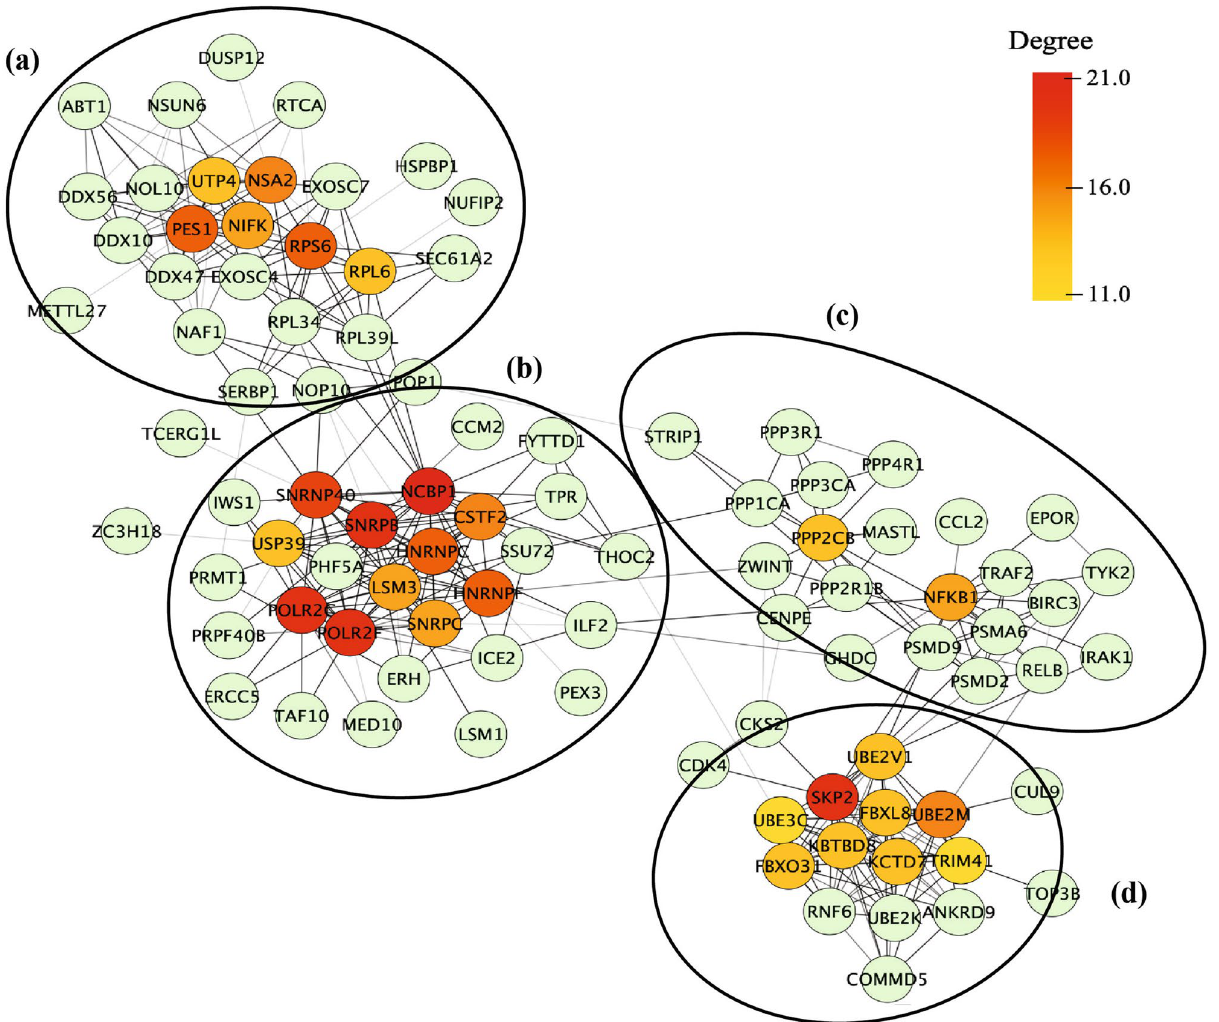
Figure 6. Diagram depicts the sub-network of the protein hubs and their first-neighboring interactors. The gradient color of yellow-to-red of the protein nodes indicates increment of the degree value for being the hub. The pale green nodes refer to the first-neighboring interactor in the network. The light-to-dark grey color of the connected lines indicates the confidence value of interaction (0.700–0.999). There are 4 clusters of nodes in which each of them is composed of DEGs involved in the regulation of gene expression ( a ), RNA processing ( b ), cell survival and cell death ( c ), and ( d ) protein degradation which indicated by the separate